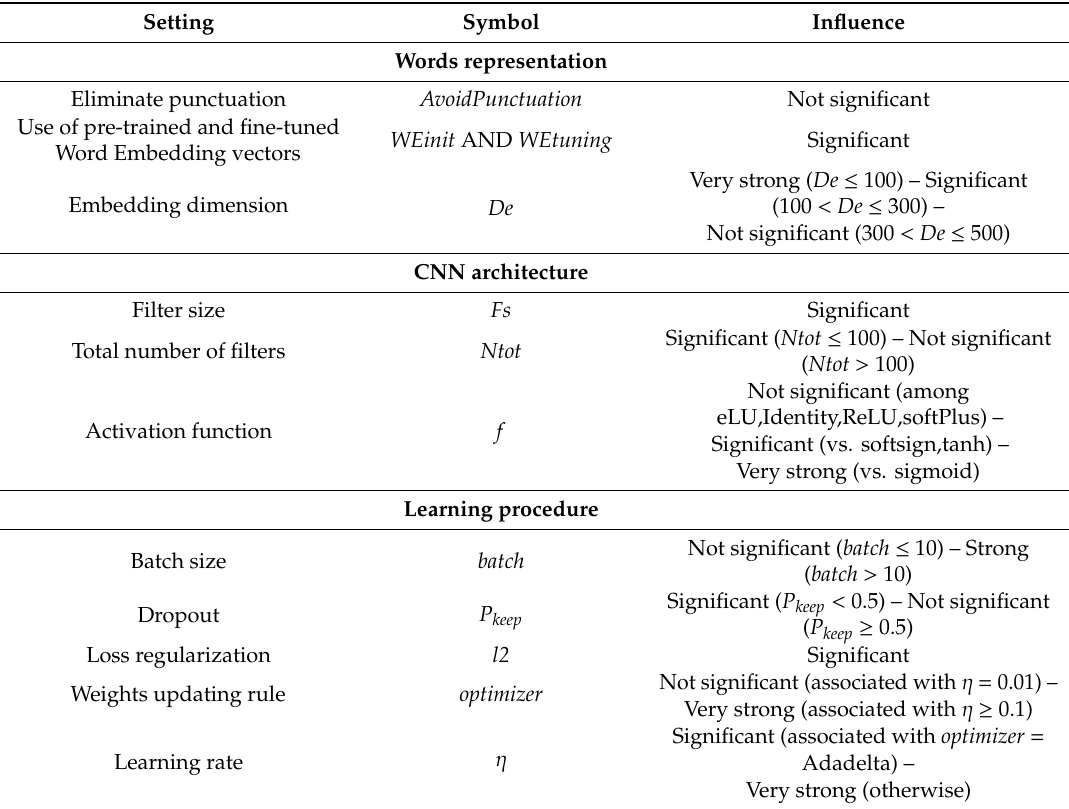
Table 17. Qualitative description of influence of